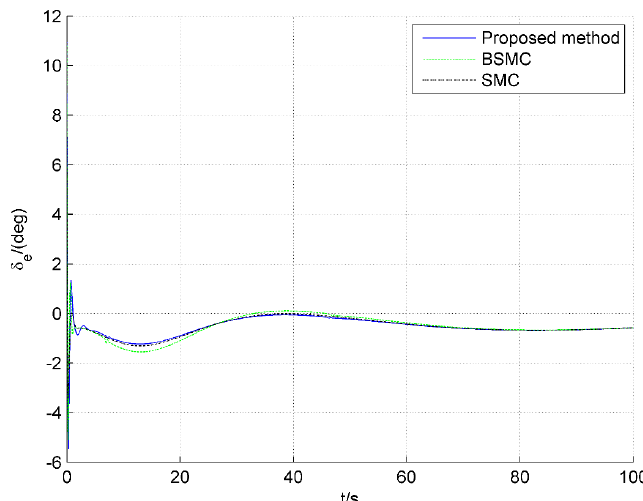
Figure 11. Responses of elevator deflection.